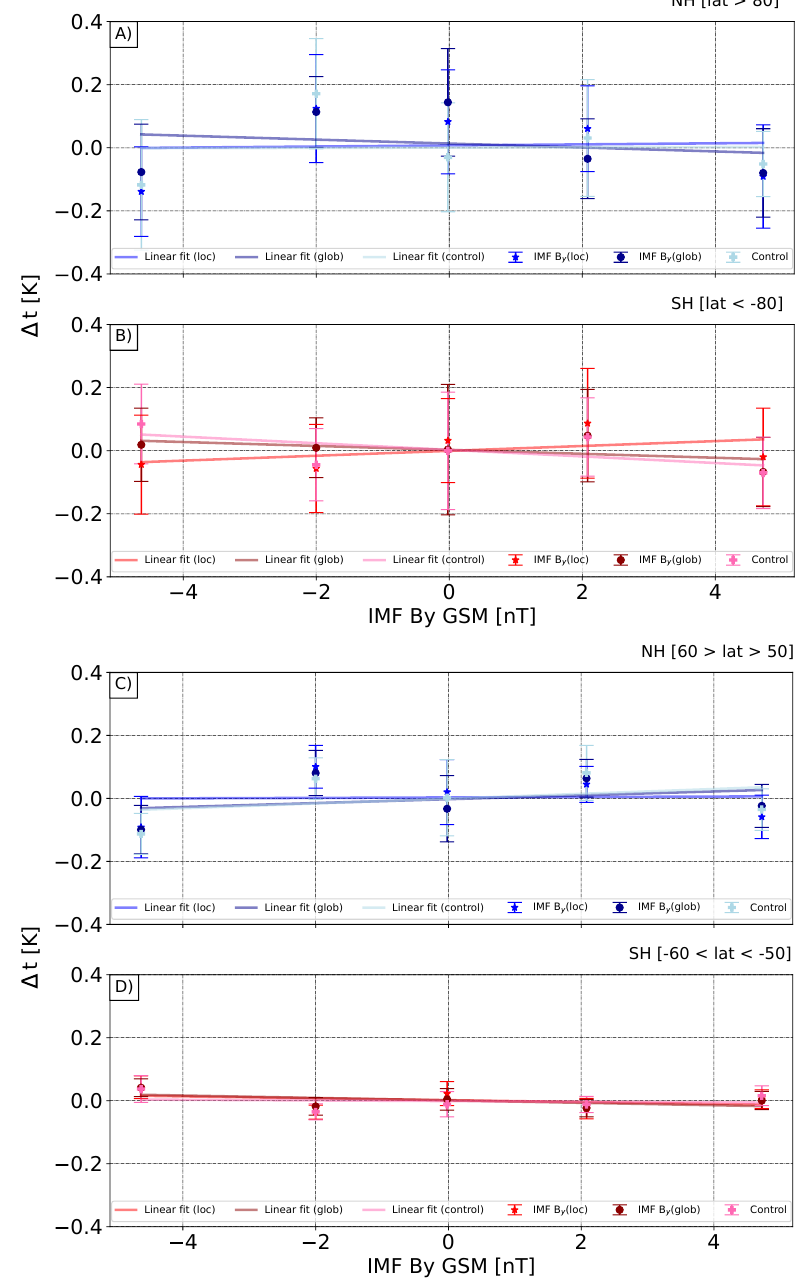
Figure 8. Ensemble-mean linear regression of ∆ t and daily-mean IMF B y for the 1999–2002 period. Data were binned and averaged for five daily-mean IMF B y intervals (see experiment description). Blue and red: B y (loc) experiment; dark blue and dark red: B y (glob) experiment; light blue and pink: the control experiment. Panels A and B: ∆ t for Northern Hemisphere ( A : lat > 80) and mid-latitudes ( B : 60 > lat > 50); panels C and D: ∆ t for Southern Hemisphere ( C : lat > 80) and mid-latitudes ( D : -60<lat<-50). Error bars are plus/minus standard-error-in-the-mean of ∆ t between ensemble members.